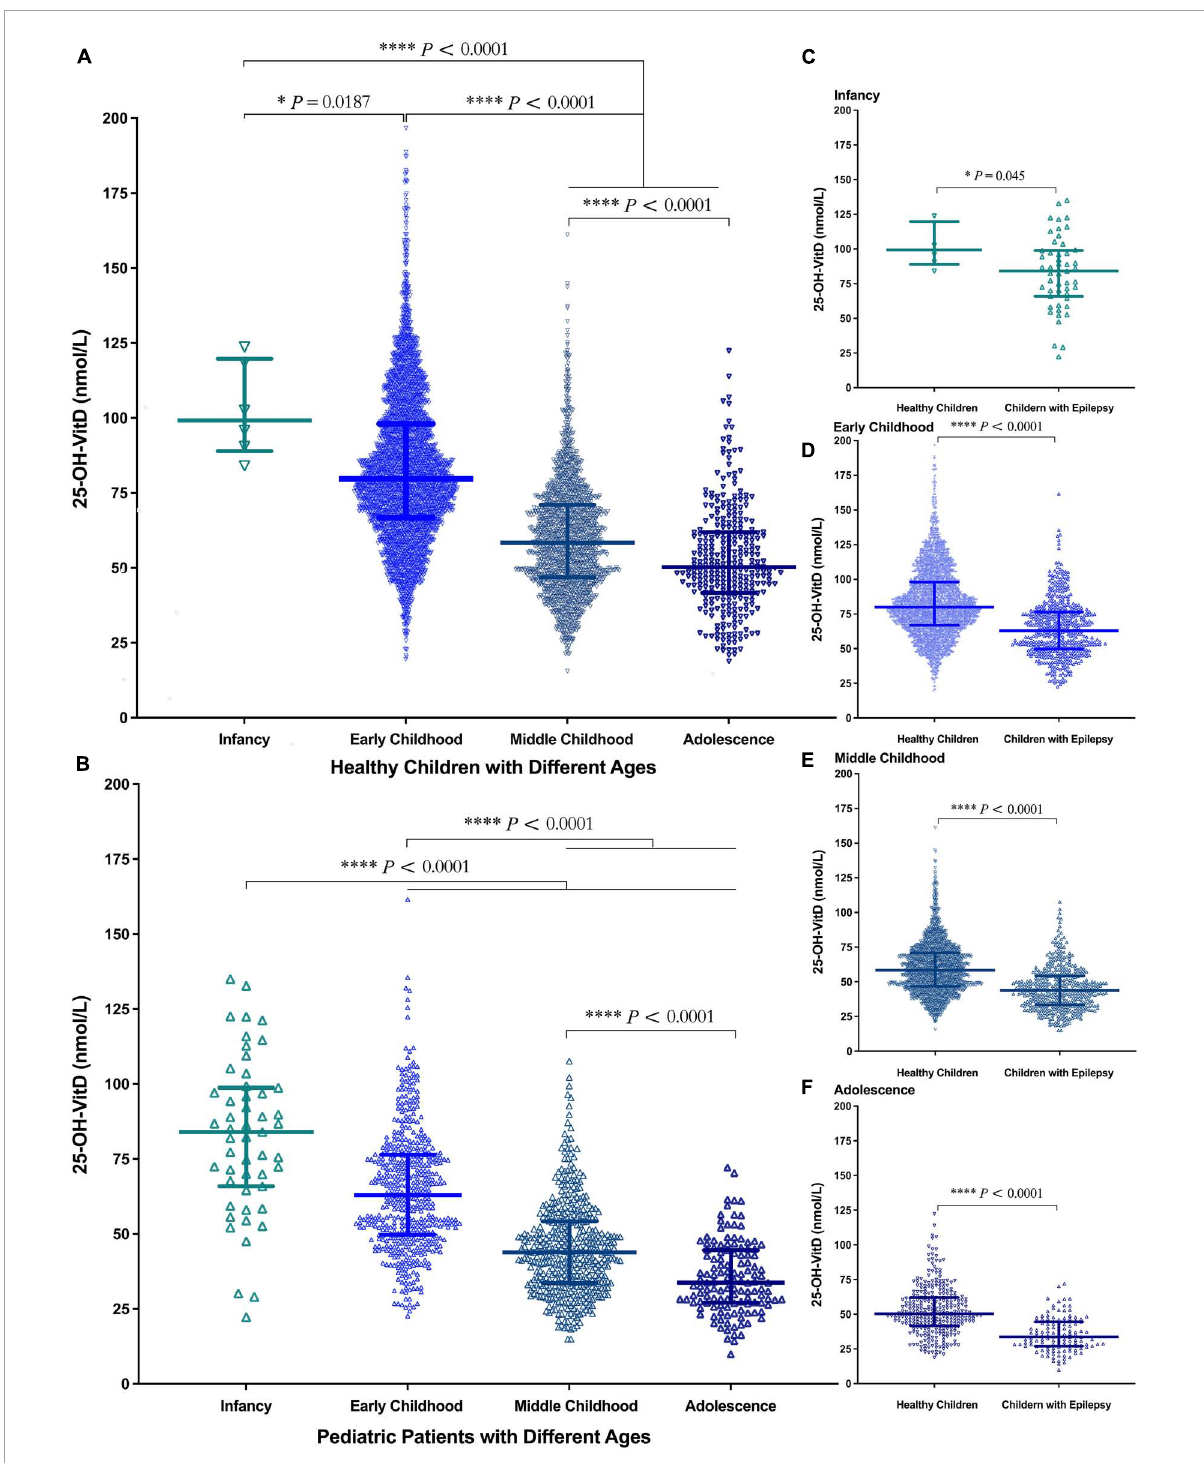
FIGURE3 Comparison in serum 25-OH-VitD status of subjects with different ages (Infancy, Early Childhood, Middle Childhood, and Adolescence). (A) Comparison in serum 25-OH-VitD status among four groups of healthy children. (B) Comparison in serum 25-OH-VitD status among four groups of children with epilepsy. (C) Comparison in serum 25-OH-VitD status between healthy children and children with epilepsy during the infancy. (D) Comparison in serum 25-OH-VitD status between healthy children and children with epilepsy during the early childhood. (E) Comparison in serum 25-OH-VitD status between healthy children and children with epilepsy during the middle childhood. (F) Comparison in serum 25-OH-VitD status between healthy children and children with epilepsy during the